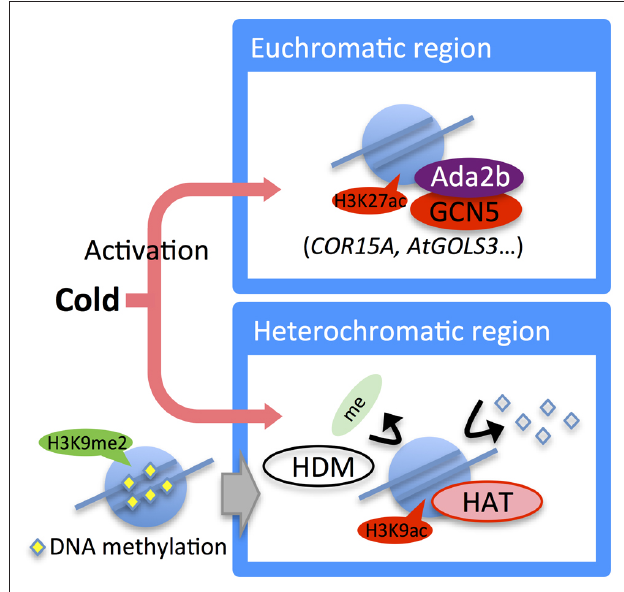
FIGURE 4 | Epigenetic regulation in the cold stress response. Expression of the HDA6 gene is induced by long-term cold treatment. Under cold stress, the histone acetylation level in cold-responsive genes (e.g., COR15A and AtGolS3 ) is increased by Ada2b and GCN5. In heterochromatic regions, H3K9me2 is removed and converted to acetylation mark. DNA methylation also